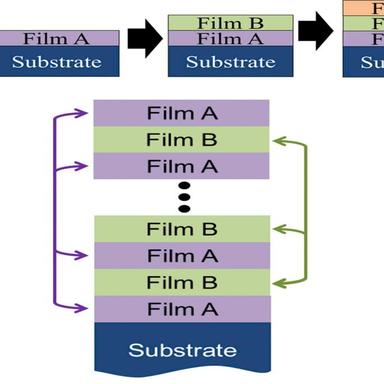
A model with multiple layers of the same material, where the optical functions are "coupled" across all layers of the same material.